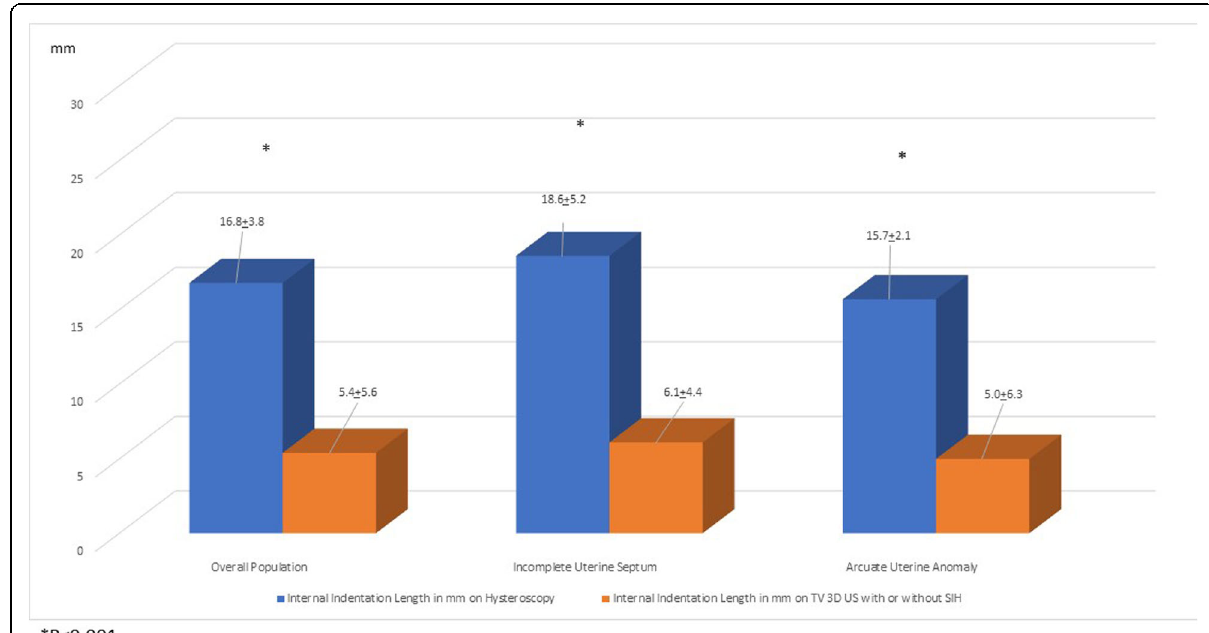
Fig. 6 Comparison between the mean IILFM measured in mm on hysteroscopy and on TV 3D US with or without SIH, in patients with IUS, significant AUA, and in the overall population in patients with significant internal indentation length ( ≥ 15